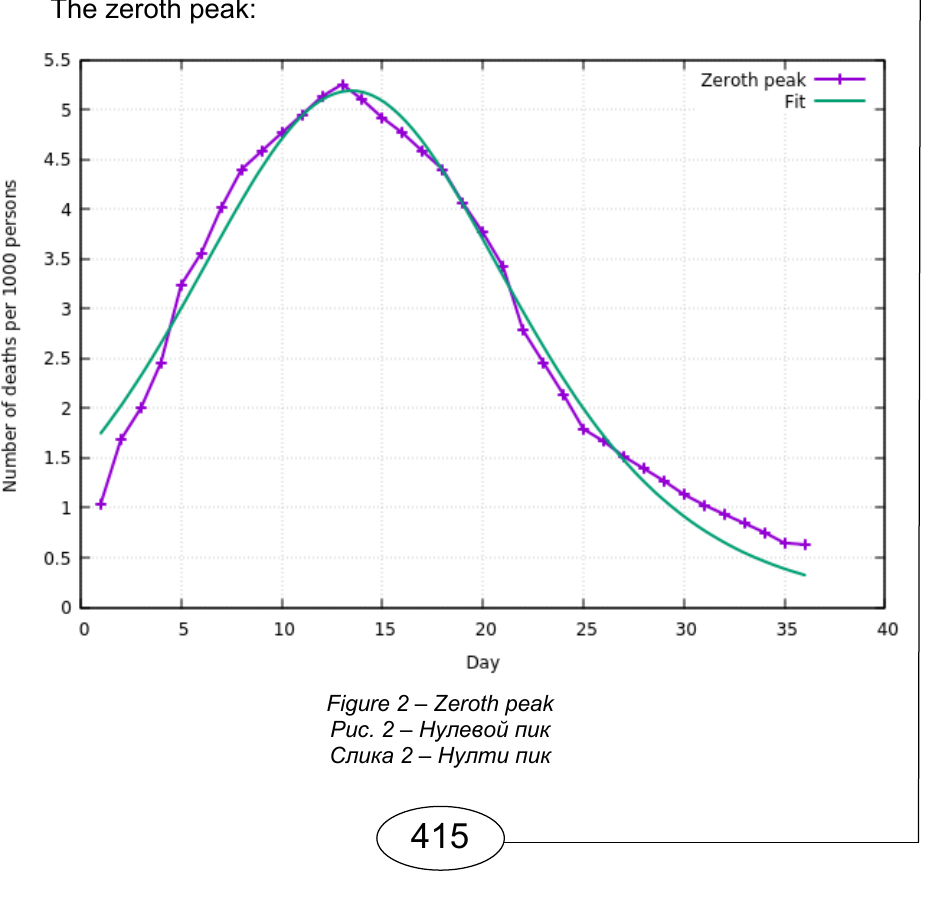
Figure 2 – Zeroth peak Рис . 2 – Нулевой пик Слика 2 – Нулти